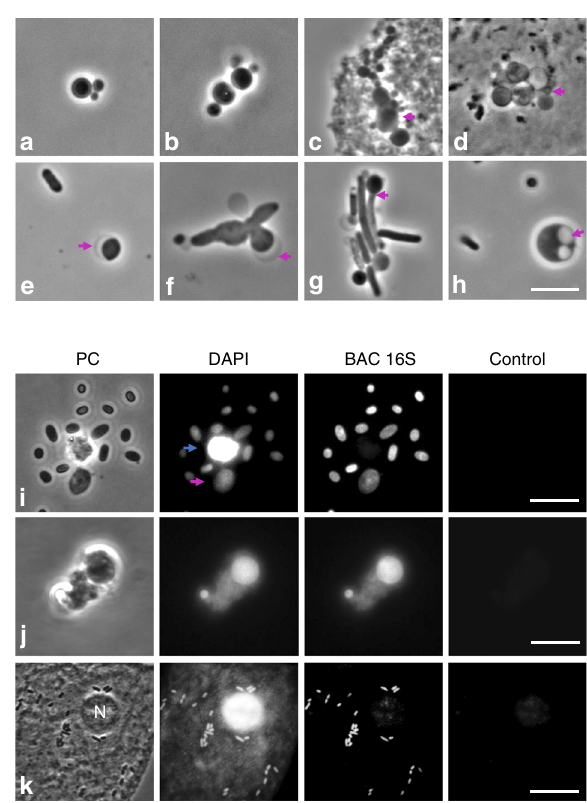
Fig. 2 L-form-like structures observed in the urine of various patients. a – h Examples of fresh urine samples assessed by phase contrast microscopy. Bundels typical of dividing L-forms ( a , b ). Magenta arrows in ( c ) and ( d ) point to putative L-form bacteria associated with sluffed eukaryotic cells; in ( e ) and ( f ) they point at crescent shaped bulges, reminiscent of the outer membrane in L-forms of Gram-negative